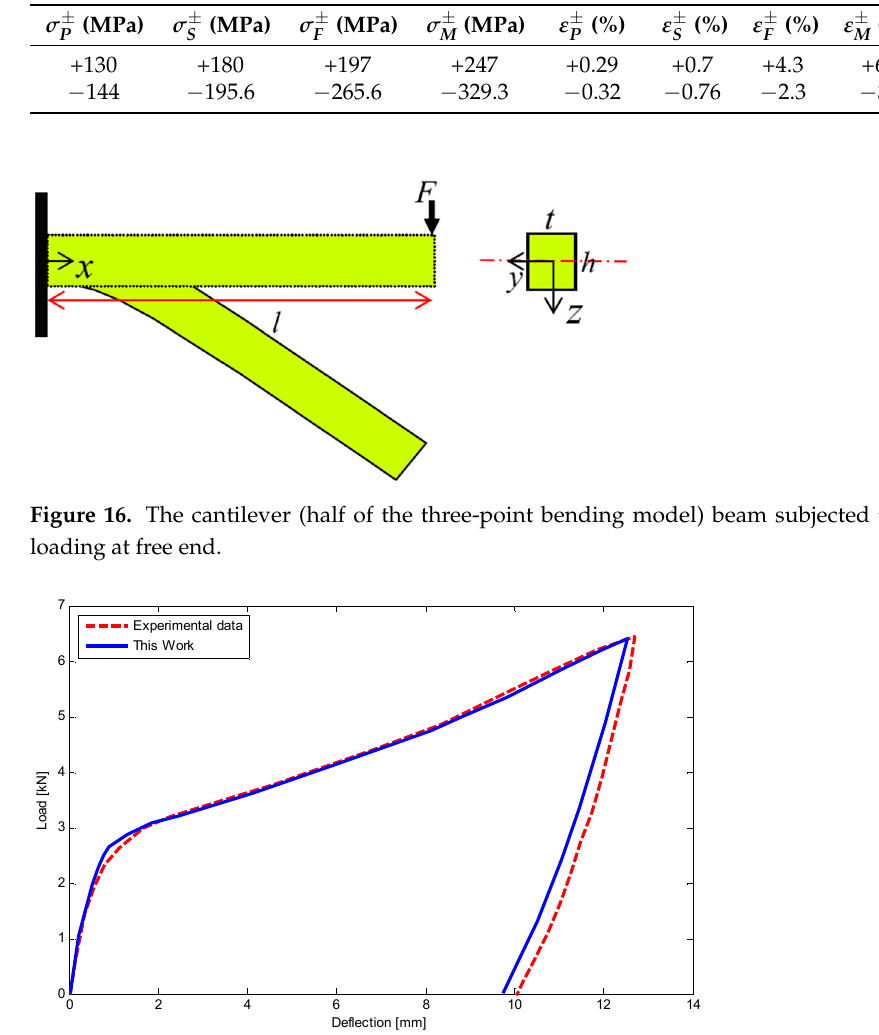
Figure 17. Comparison of load and deflection for a rectangular SMA beam subjected to the three-point bending test at room temperature.